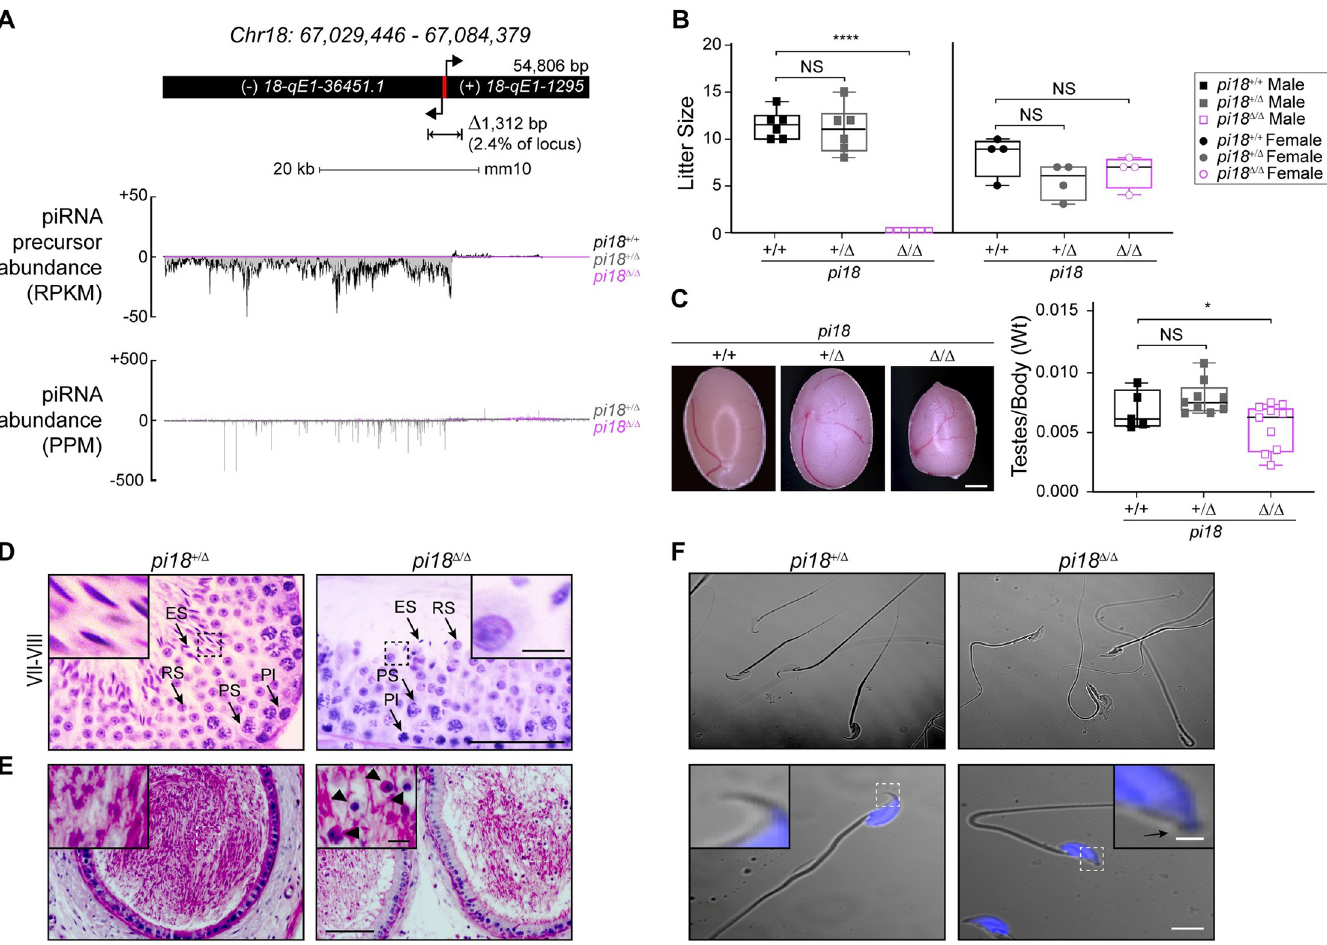
Fig 1. Pachytene piRNA derived from pi18 is essential for spermatogenesis and male fertility. (A) Schematic diagram of the Chr18 piRNA coding region and the DNA fragment deleted using CRISPR/Cas9 to generate bi-directional promoter deletion ( Δ / Δ ) mutant mice (top). Red bar, A-MYB and BTBD18 binding loci. Precursor and mature piRNA abundance at pi18 piRNA cluster in P28 testes of wild-type (+/+), heterozygous (+/ Δ ) and homozygous ( Δ / Δ ) mutant mice (bottom). RPKM, reads per kilobase million; PPM, parts per million reads. (B) Average litter size of adult male (squares, n = 6) and female (circles, n = 4) controls and mutant mice. (C) Representative macroscopic appearance (left) and quantification (right) of testes weight of 8 wk/old controls and mutant mice ( n � 10 per each genotype). Scale bar, 2 mm. (D) Testicular sections from 8 wk/old mice were stained with periodic acid-Schiff (PAS) and hematoxylin (H) ( n = 3). Stage of seminiferous epithelium cycles was determined by morphology of spermatocytes and rounds spermatids. Pl, preleptotene spermatocyte; PS, pachytene spermatocyte; RS, round spermatid; ES, elongating spermatid. Scale bar, 50 μ m; inset, scale bar, 5 μ m. (E) PAS&H staining of cauda epididymis from 12 wk/old mice ( n = 2). Black arrowheads, sloughing germ cells. Scale bar, 50 μ m; inset, scale bar, 5 μ m. (F) Representative differential interference contrast (DIC) micrograph images of sperm from 12 wk/old mice, with nuclei counterstained with Hoechst 33342 (blue) ( n = 3). Scale bar, 5 μ m; inset, scale bar, 0.5 μ m; Arrow, apical hook. B, C The box indicates median ± interquartile range, the whiskers indicate the highest/lowest values and midlines are median values. NS, not significant, � P < 0.05, ���� P < 0.0001.